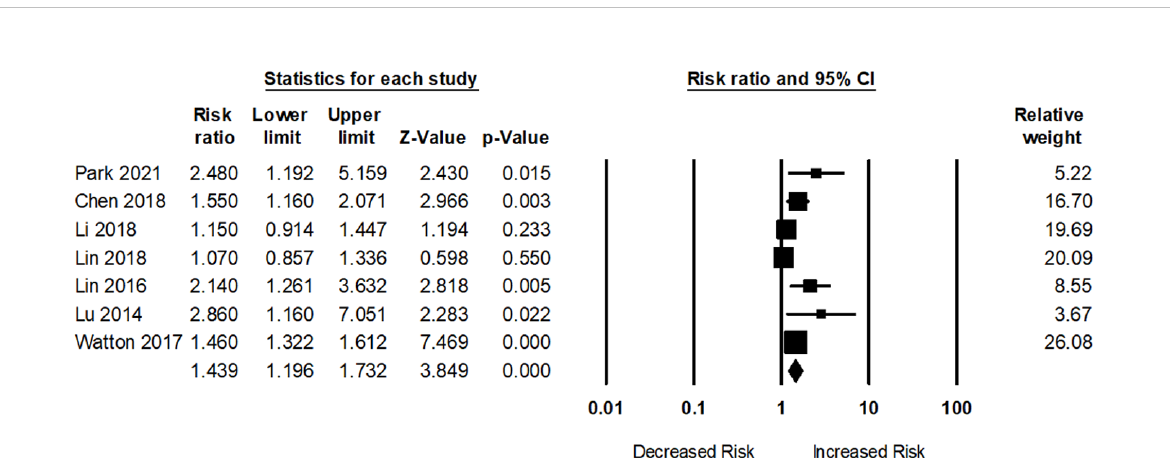
FIGURE 3 Association between systemic lupus erythematosus (SLE) and dementia risk.